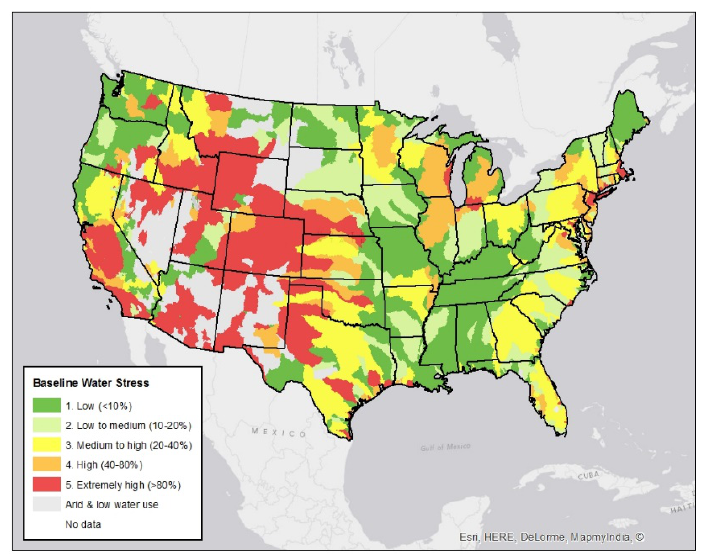
Figure 1. Baseline Water Stress Map of the United States, Source: U.S. Geological Survey National Water Information System, https://waterdata.usgs.gov/nwis [9].